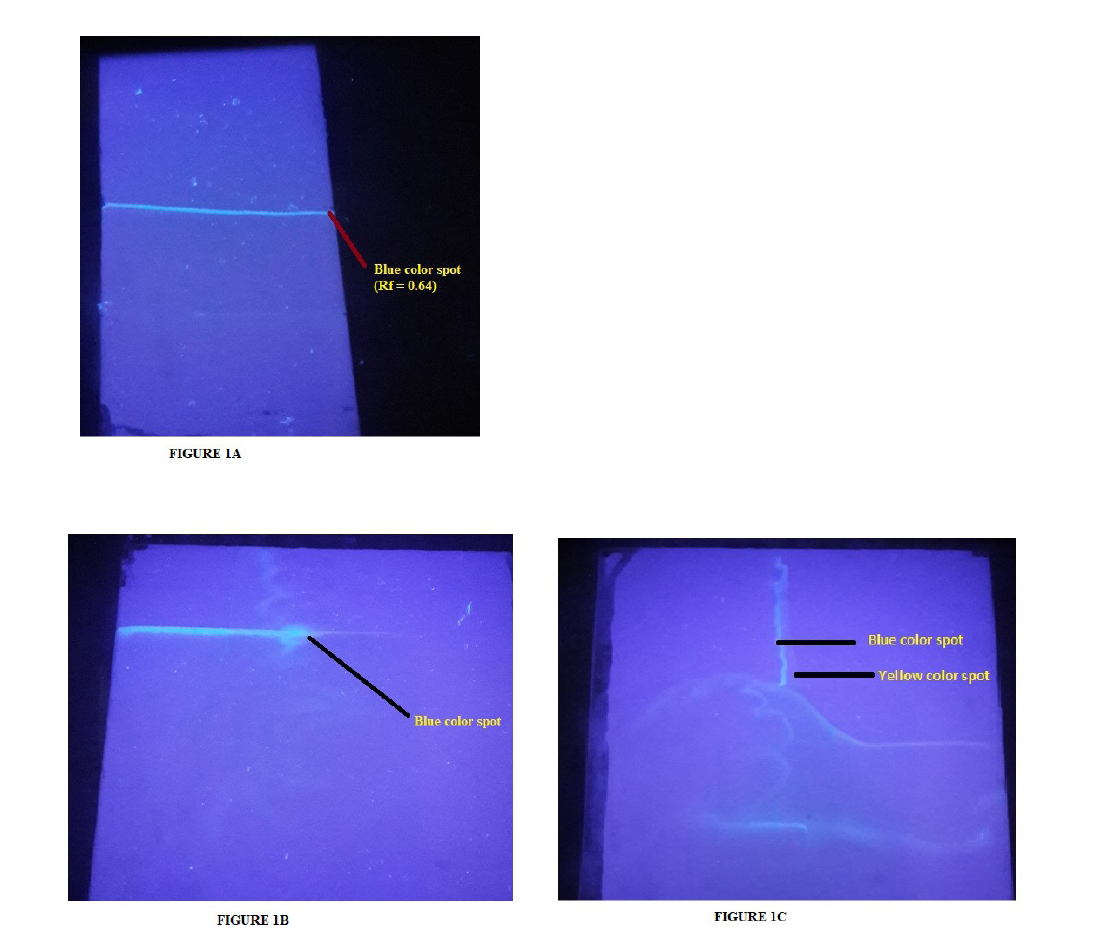
FIGURE 1 -( A): One dimensional thin layer chromatogram of methanolic extract of Pandanus odoratissimus developed and visualized under far UV light; Preparative thin layer chromatogram (PTLC) developed and visualized under far UV light (B): One dimensional view; (C): Two dimensional view.